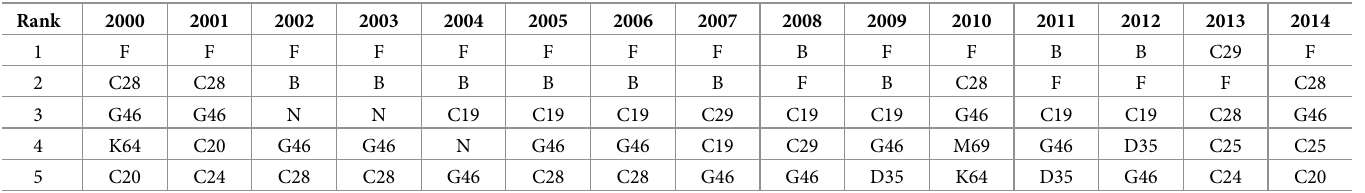
Table 8. Five-highest circulated sectors in European community.